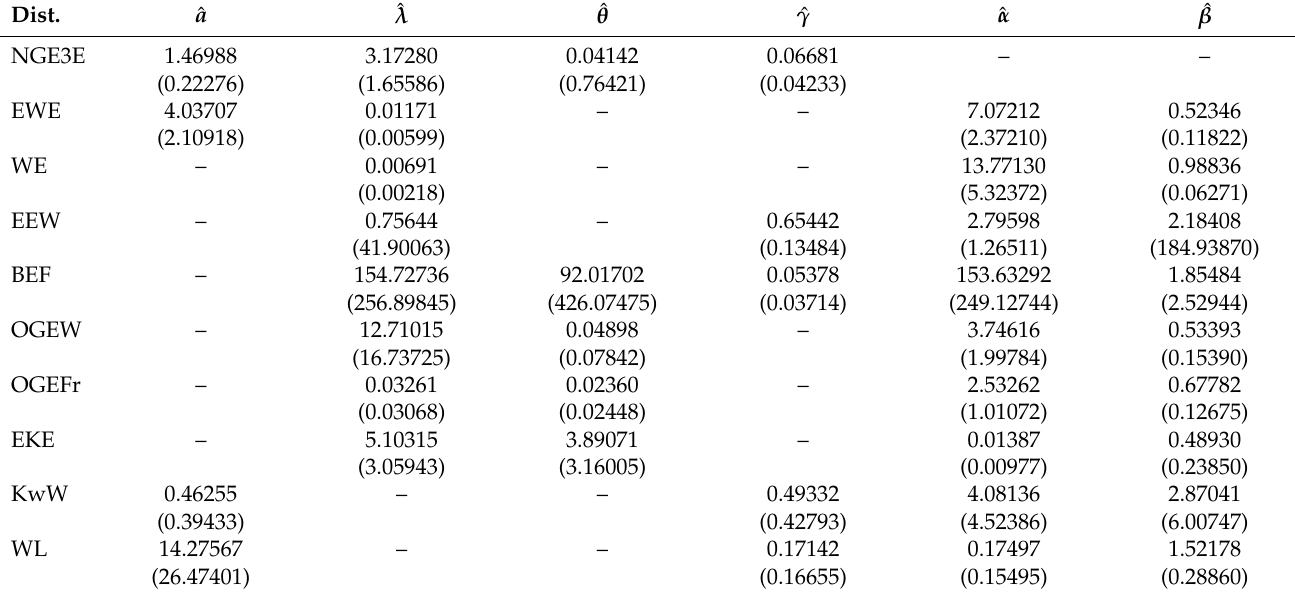
Table 4. MLEs with SE (in parentheses) of CMs for bladder-cancer